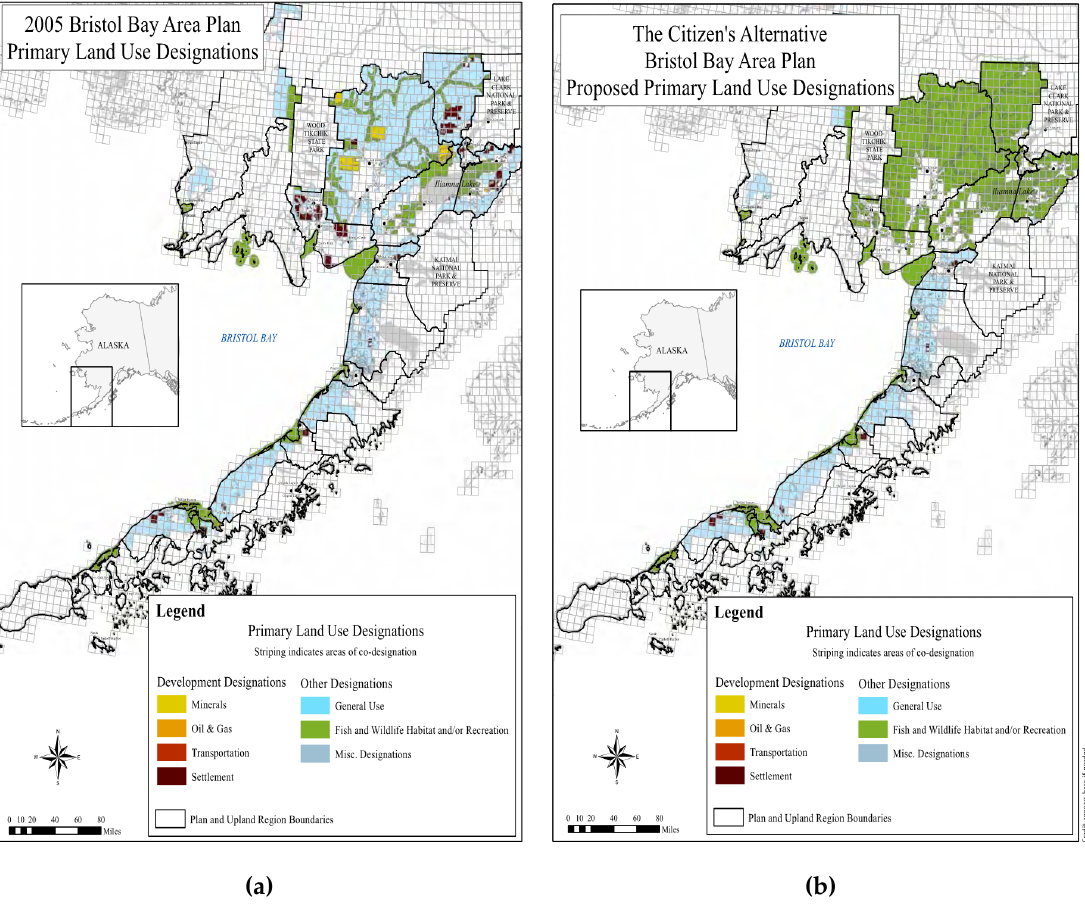
Figure 1. Land use designations in (a) 2005 BBAP and (b) Citizen’s Alternative. Fish and wildlife habitat areas are shaded in green in both (from a PowerPoint presentation prepared by Wild Salmon Center, 2013, reproduced by permission from the Citizens’ Alternative Bristol Bay Area Plan).